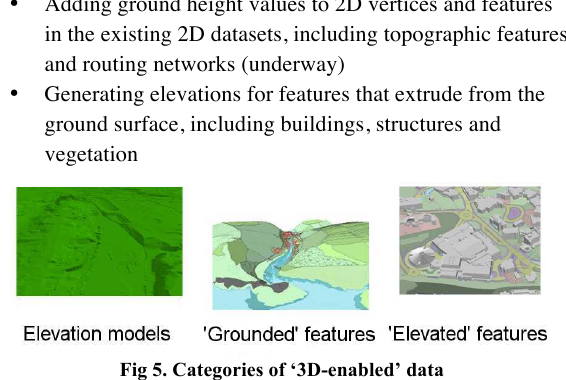
Fig 5. Categories of ‘3D-enabled’